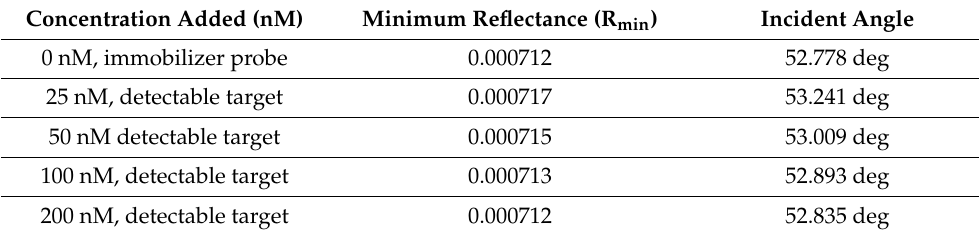
Figure 7. Reflectance and incident angle graph for different detectable targets. The value of minimum reflectance and incident angle for these concentrations has been shown here using Table 5. Table 5. R min and incident angle values for different target concentrations.